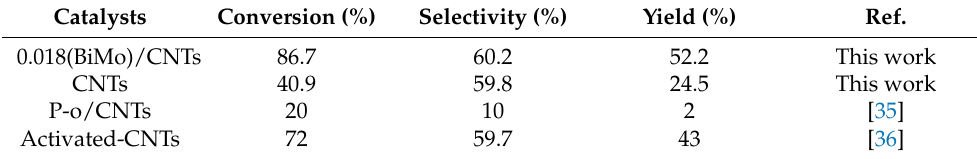
Table 2. Comparison of catalytic performances for different catalysts under no steam.